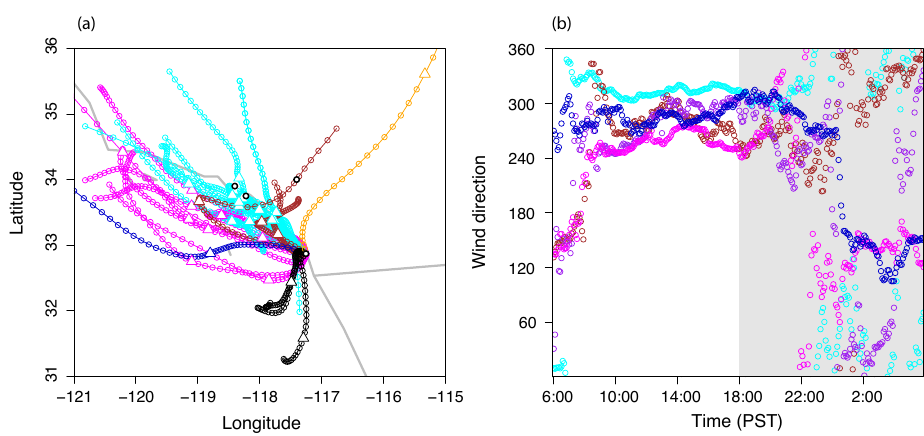
Fig. 1. (a) : Averaged 48-h back trajectories for each day (daytime only) representing Los Angeles-Long Beach (cyan; air mass coming from Los Angeles and Long Beach regions), Riverside (brown; air mass originating from Riverside vicinity), Inland (orange; easterly/northeasterly air mass), Tijuana-Ensenada (black; southerly air mass), Mixed coastal (magenta; northerly air mass coming along the coast of California), and Ocean (dark blue; westerly air mass) air mass sectors during the campaign. The triangle in each trajectory indicates 24-h before the air mass arrived at the sampling site. The black circles (from top to bottom) indicate Riverside, Los Angeles, Los Angeles – Long Beach port, and the sampling site; (b) vector-averaged diurnal profile of wind direction (0 degree represents wind coming from north) for the air mass sectors specified in (a) . Shaded areas indicate nighttime periods.